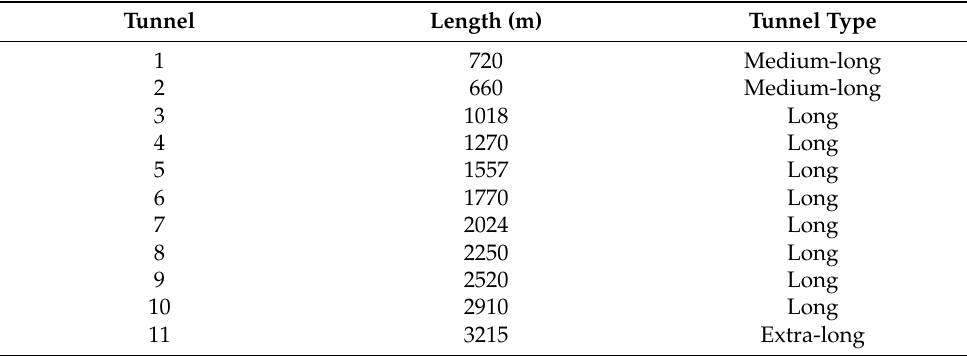
Table 4. Basic characteristics of the eleven examined tunnels.